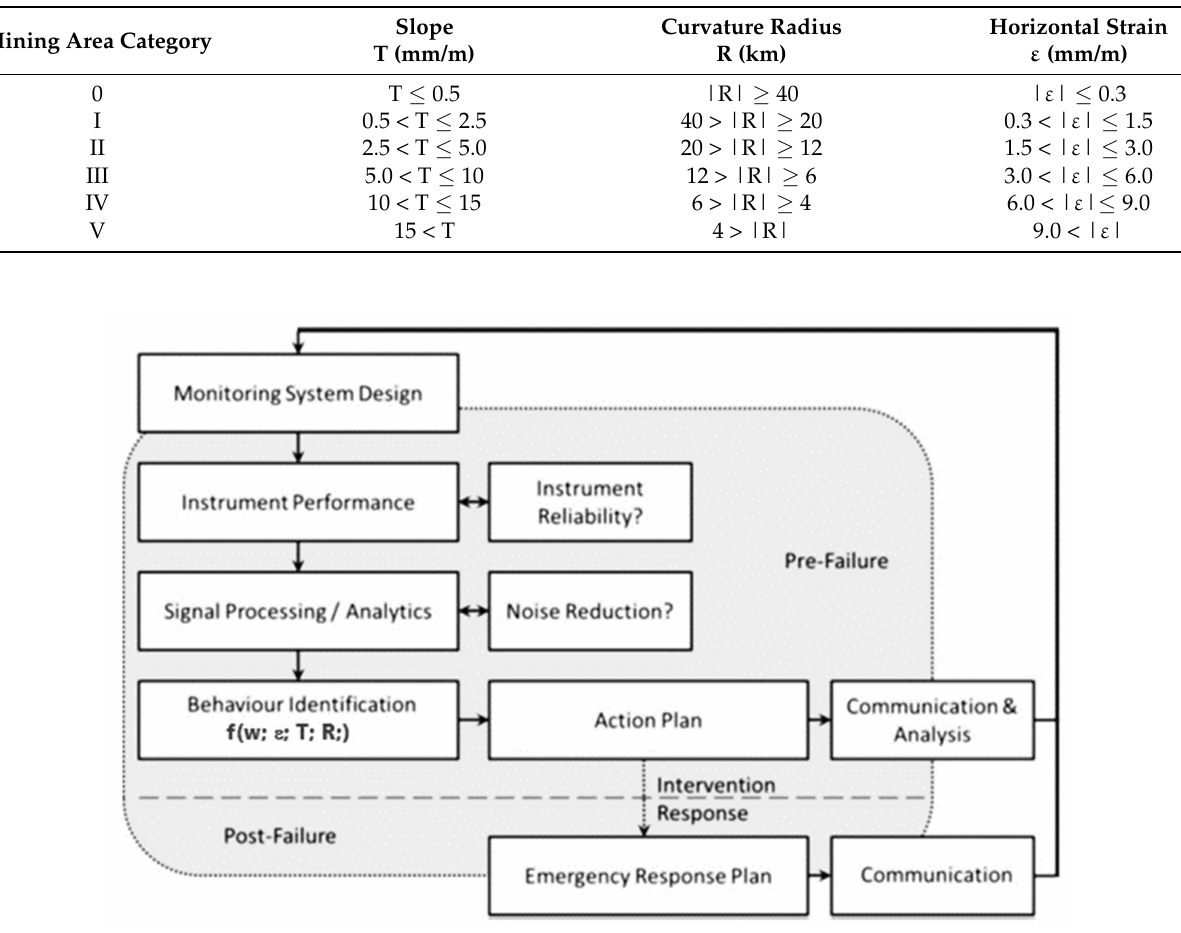
Figure 1. Scheme for the road structure monitoring process for the implementation of the safe operation process with the assumed investment